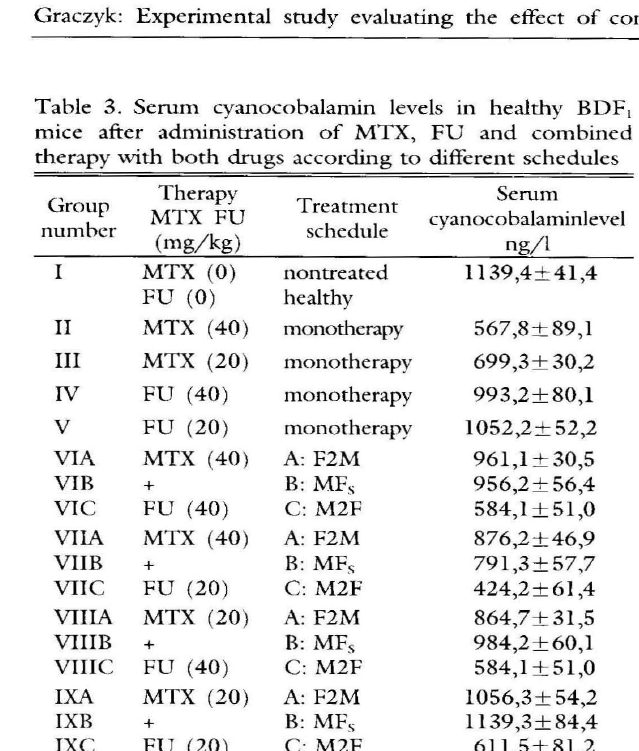
Table 3. Serum cyanocobalamin levels in healthy BDFl mice after administration of MTX, FU and combined therapy with both drugs according to different schedules